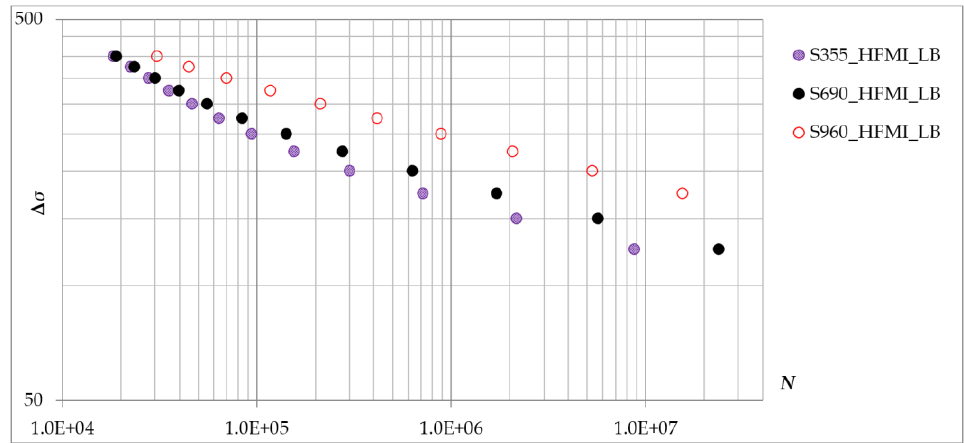
Figure 14. Results of calculated fatigue life for S355, S690 and S960 (HFMI condition, LB).